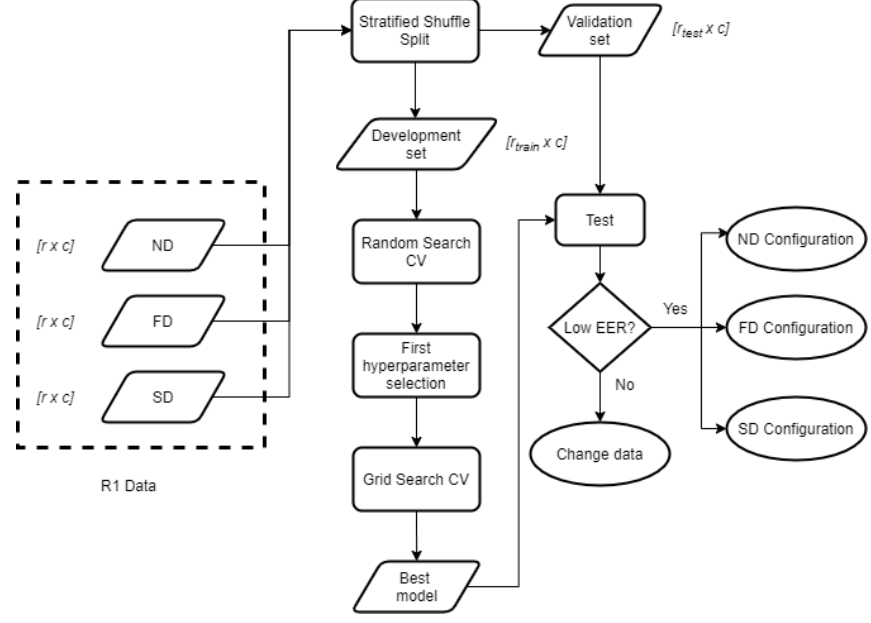
Figure 4. Hyperparameter tuning